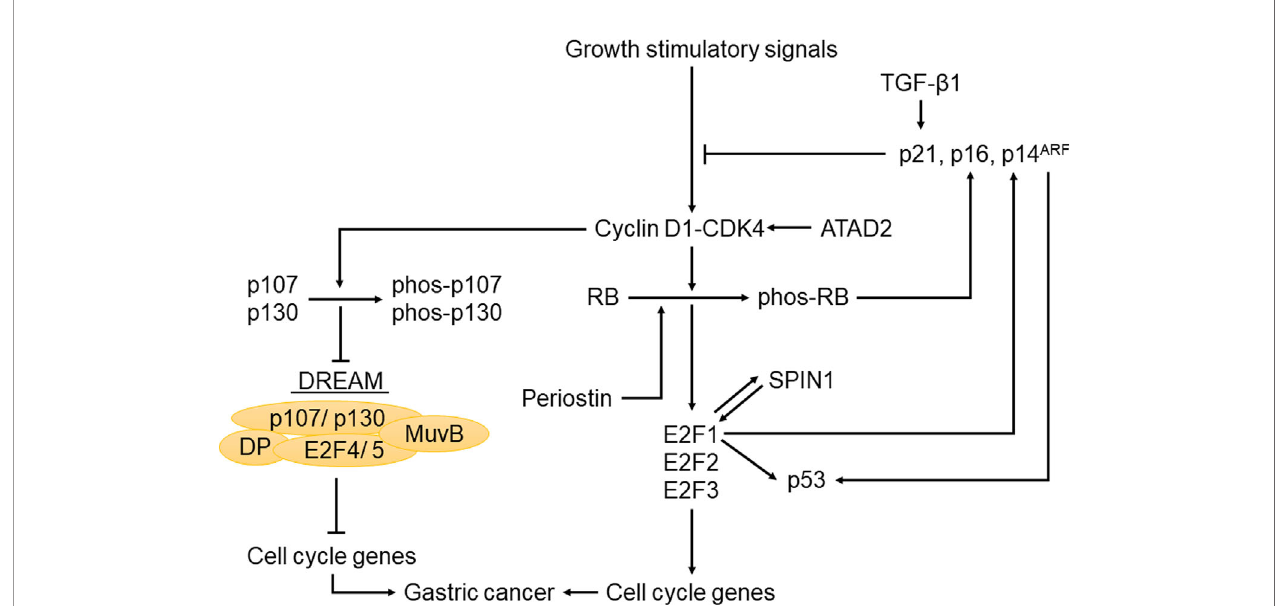
FIGURE 2 | The regulatory network of the RB-E2F pathway in gastric cancer. When cells receive growth stimuli, activation of CDKs leads to the phosphorylation of pocket proteins, collapse of the previously formed RB-E2F complexes and DREAM complexes. The subsequent release of E2F1-3 can activate target genes required for cell cycle entry. Meanwhile, this pathway is also regulated by upstream and downstream molecules in gastric cancer, such as CKIs, p53, TGF- b 1, ATAD2 and